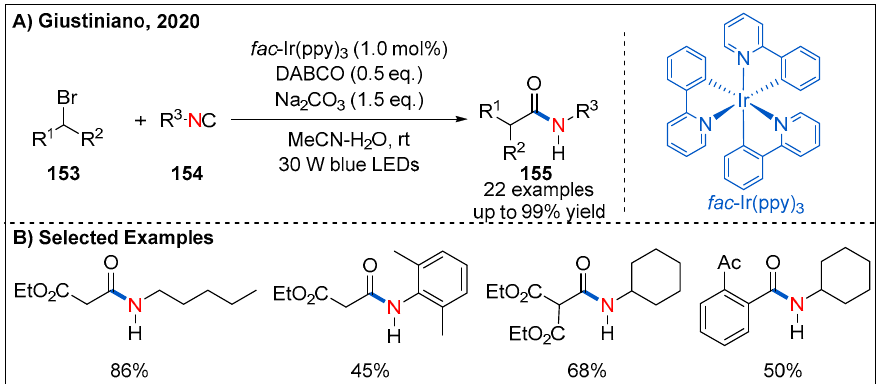
Figure 46. Visible-light-promoted photoredox-catalyzed amide synthesis from electron-poor al- kyl/aryl bromides and